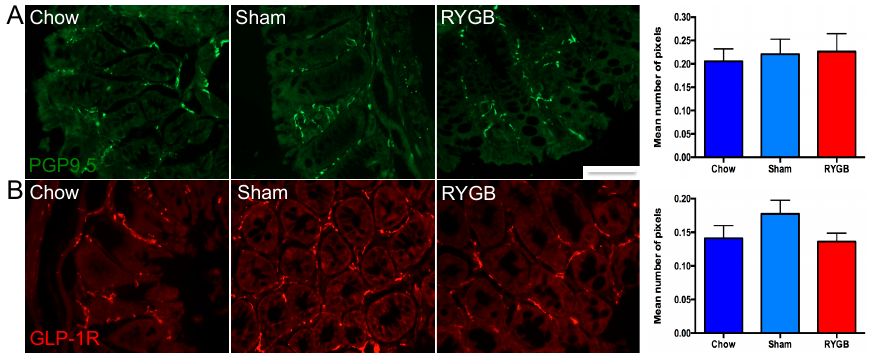
Figure 4. Expression of pan-neuronal marker PGP9.5 (green) is unchanged between chow, sham, and RYGB groups, as demonstrated by images showing consistent neuronal expression surrounding mucosal crypts ( A ). Quantification of PGP9.5 immunoreactivity (IR) in colonic mucosa showed no difference in the number of positive pixels between the three groups ( B ). GLP-1 receptor expression was found in close apposition to the basal end of colonocytes (red), and quantification of pixels showed no change in IR between the groups. N = 5–7. The error bars show SEM, and the scale bar = 10 µ m.